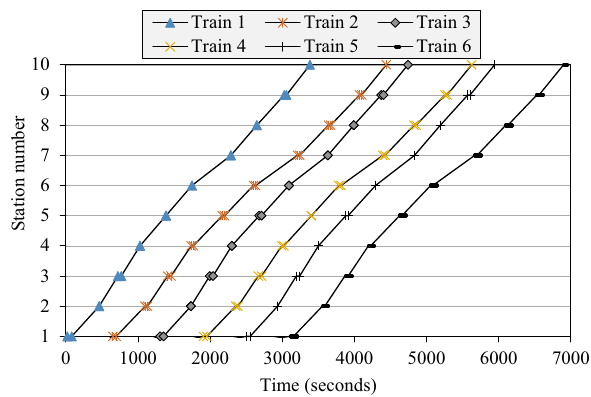
Fig. 3 The time–space graph of the